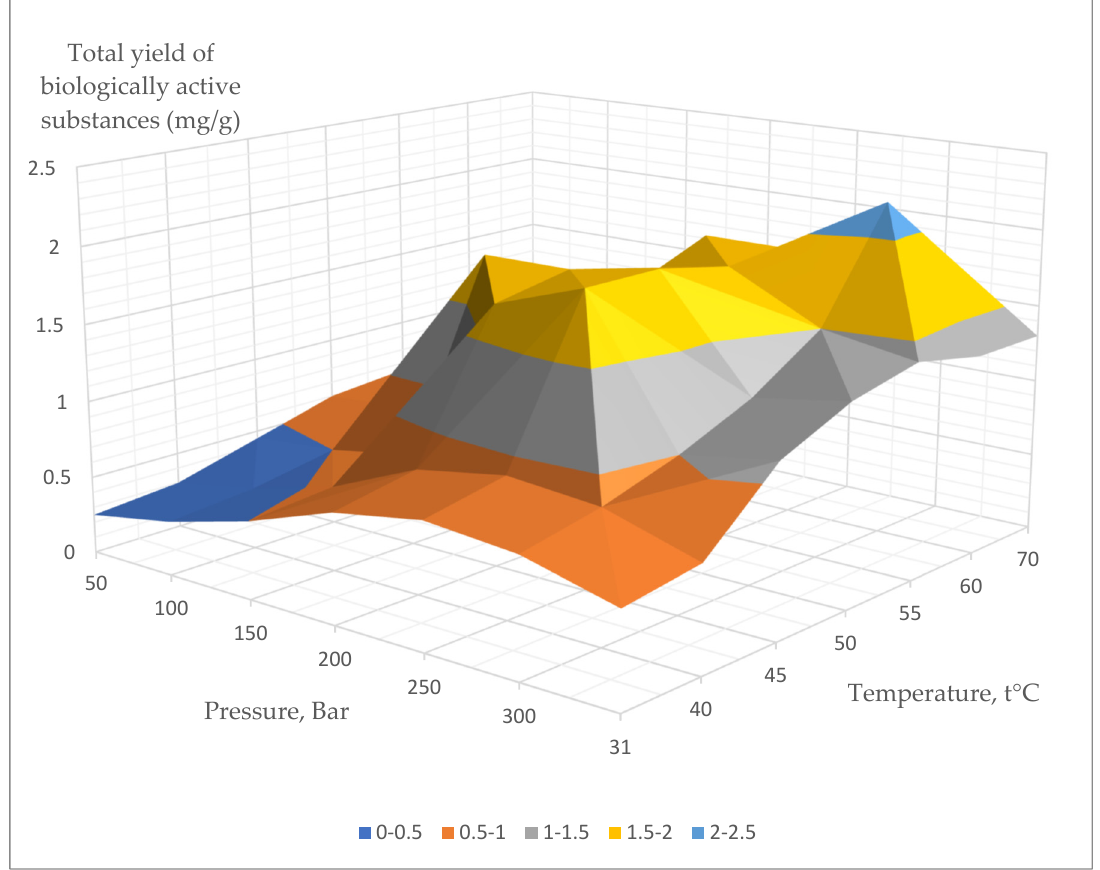
Figure 2. 3D–graph data of supercritical CO 2 -extraction. Total yield of biologically active substances from extracts of Z. marina (old seagrass ejection on the surf edge).